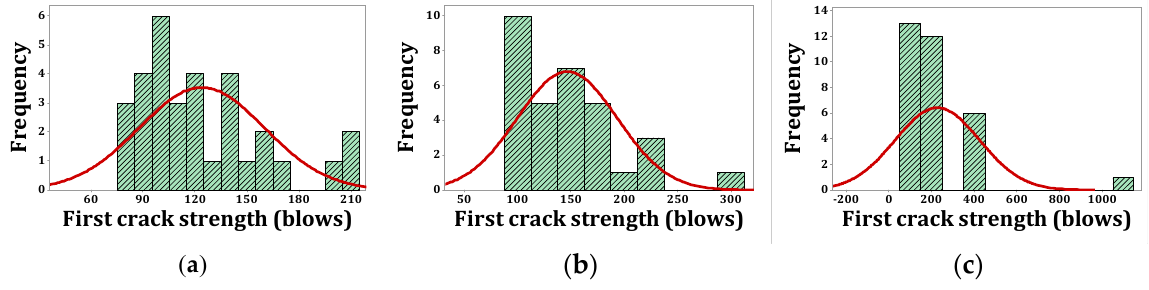
Figure 15. Normal probability plots for first crack (humid): ( a ) F5, ( b ) F2F3.